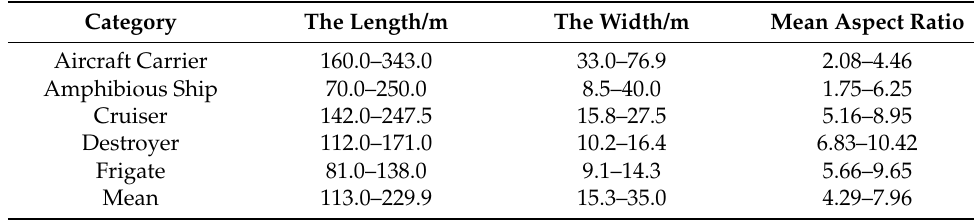
Table 1. The summary of common ship size.